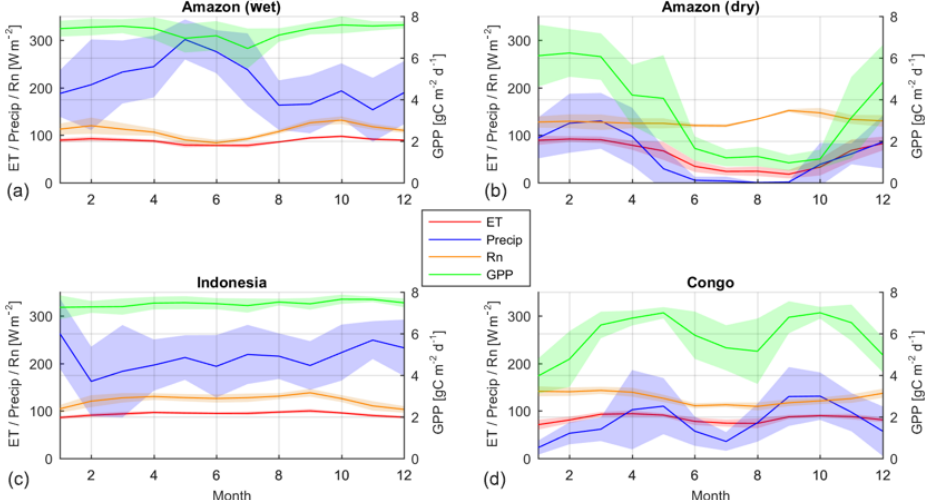
Figure 3. Seasonal variations in evapotranspiration (ET) from WECANN, precipitation (Precip) based on GPCP in units of energy (Wm − 2 ; by multiplying it by the latent heat of vaporization), net radiation (Rn) from CERES, and gross primary production (GPP) based on WECANN informed by solar-induced fluorescence (SIF) over the wet part of the Amazon (a) , over the Savanna region of Brazil (b) , over Indonesia (c) , and over the Congo Basin (d) .